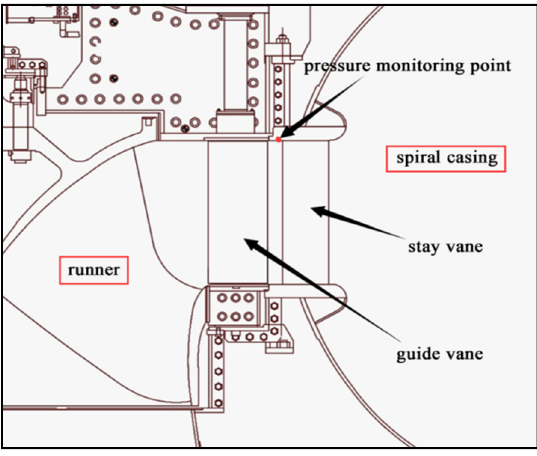
Figure 6. Location of the pressure monitoring point.